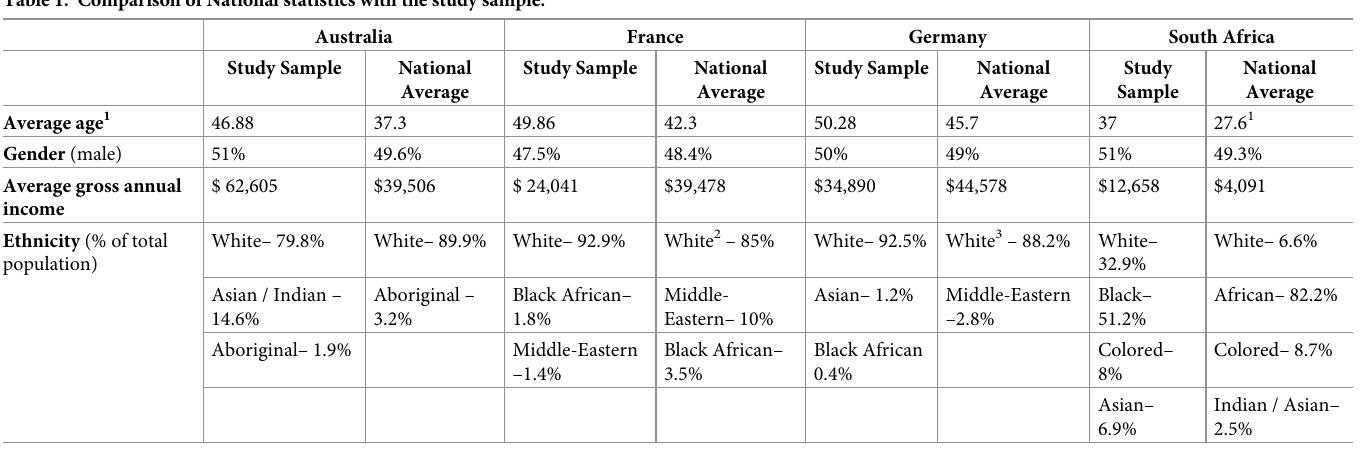
Table 1. Comparison of National statistics with the study sample.